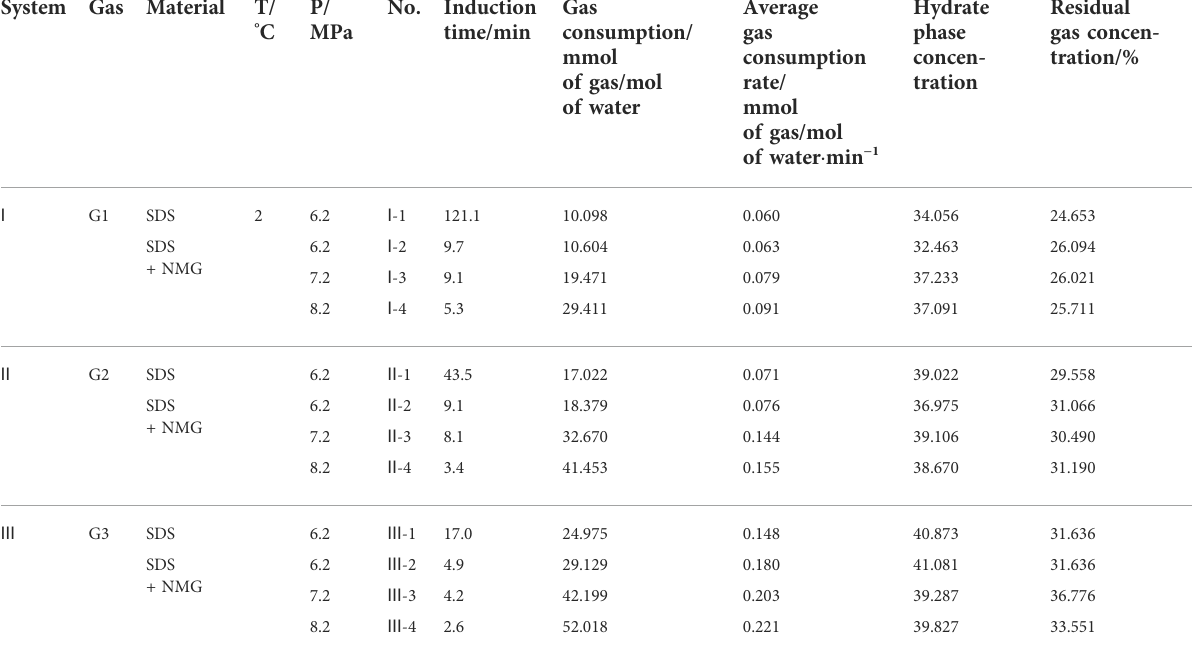
TABLE 1 Experimental conditions and formation results of gas hydrates under different conditions. System Gas